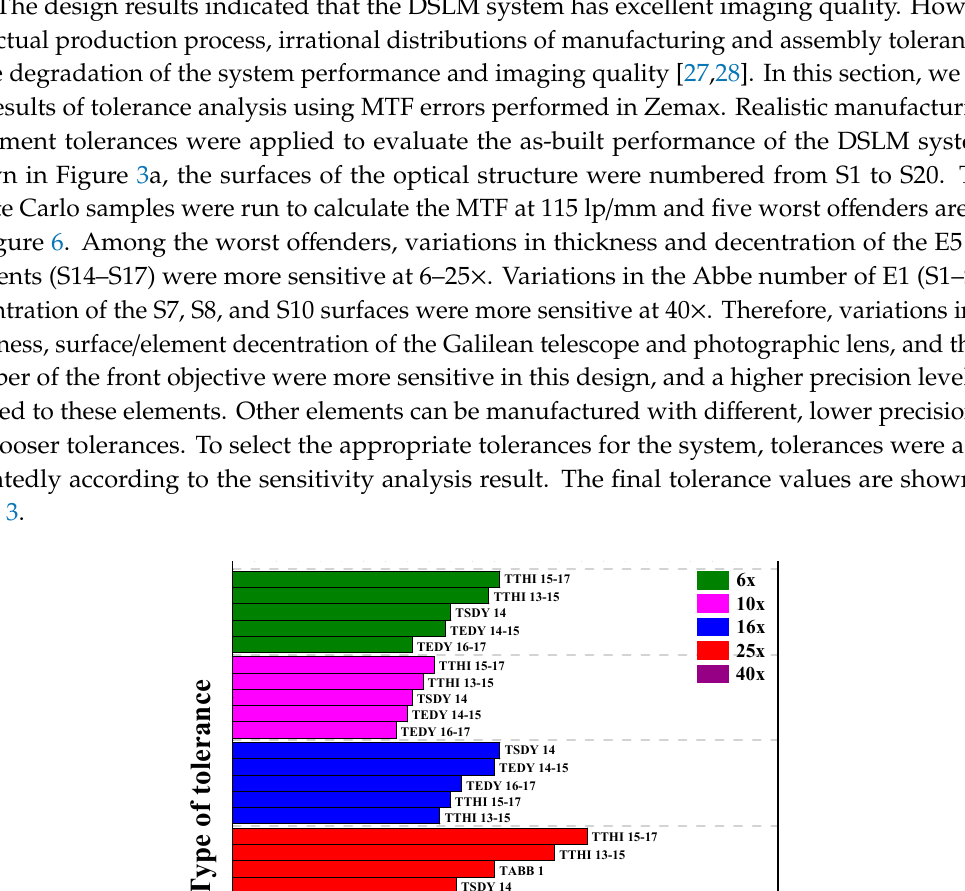
Table 3. System tolerances.